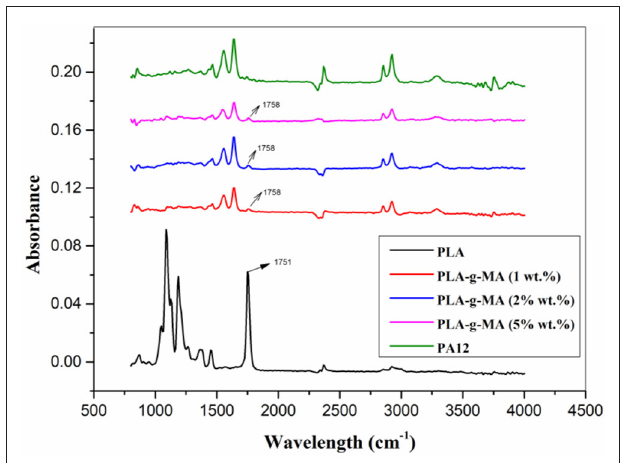
FIGURE 9 | FTIR studies of PLA/PA12 blends with varying content of compatibilizers.